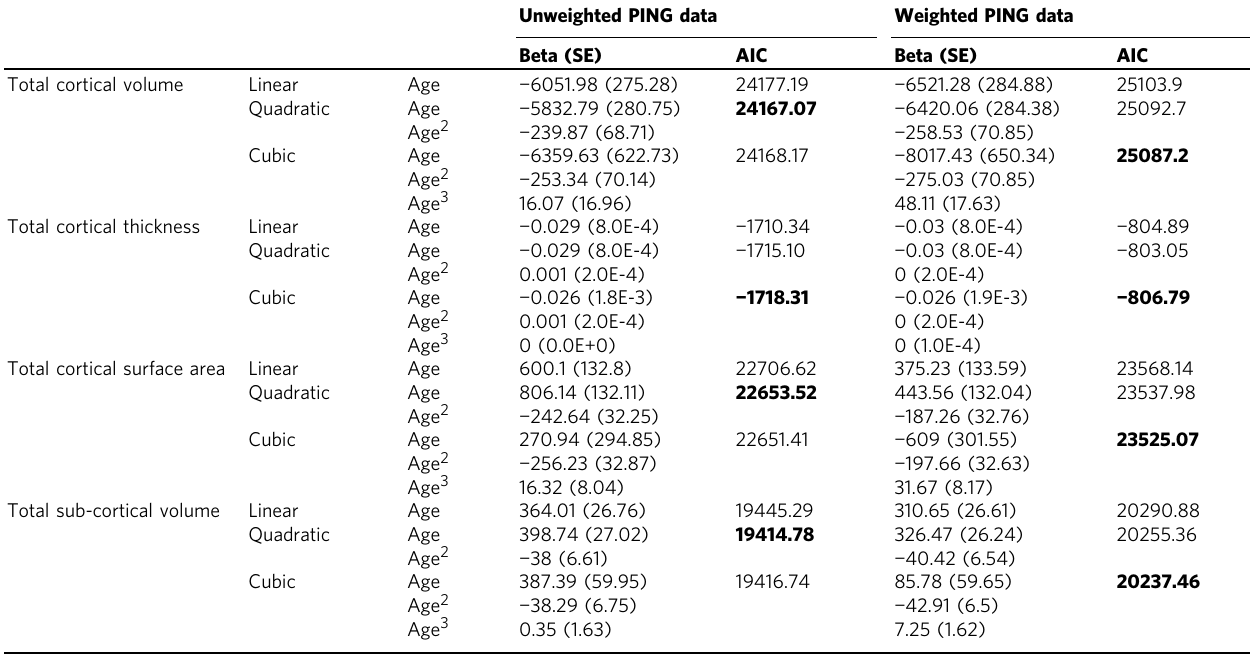
Table 2 Best- fi tting models for global measures of brain